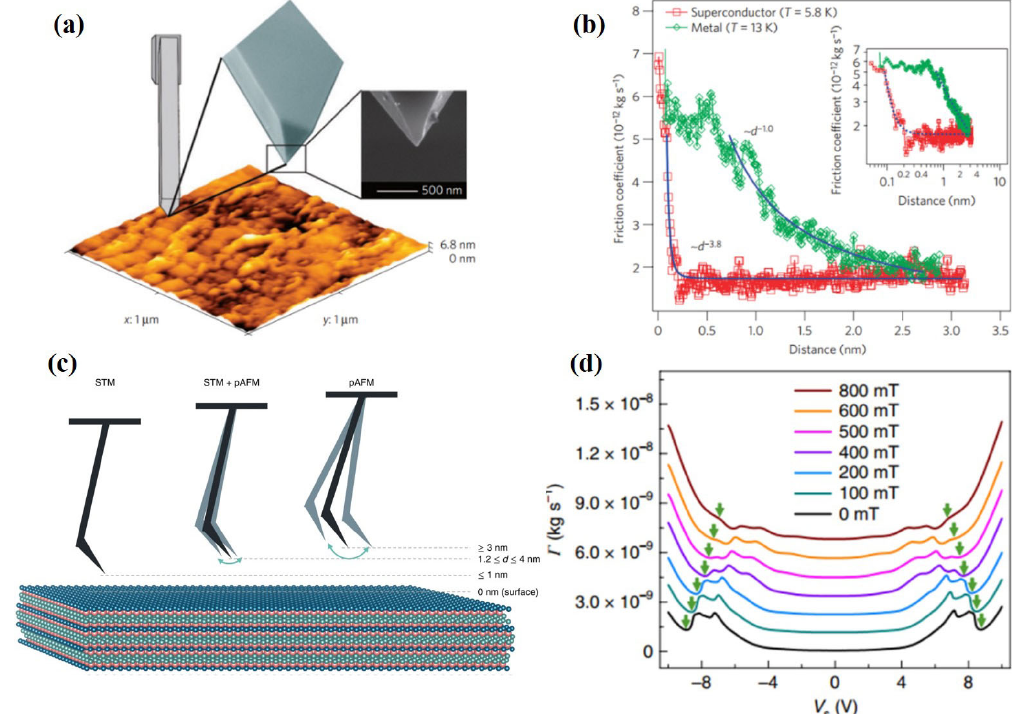
Fig. 7 Non-contact friction experiment with electrons and phonons: (a) pAFM, (b) relationship between non-contact friction coefficient Γ and probe-sample distance d , (c) combined STM–pAFM measurements, and (d) dissipation–bias curve under different applied magnetic fields. Reproduced with permission from Ref. [39] for (a, b), © Macmillan Publishers Limited 2011; Ref. [88] for (c, d), © The Author(s), under exclusive licence to Springer Nature Limited